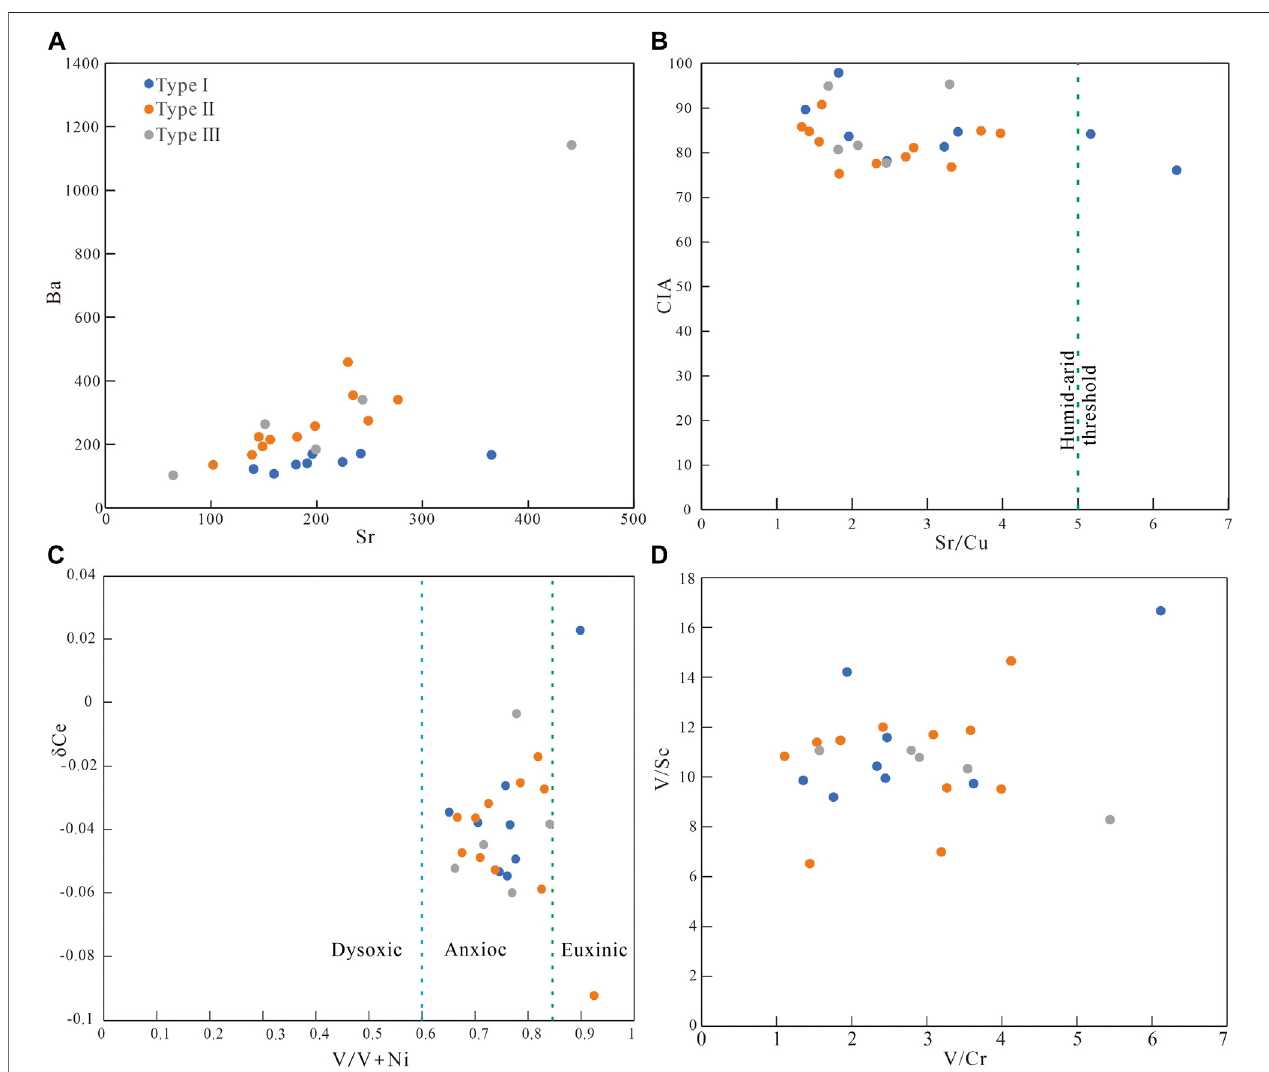
FIGURE 9 | Distribution diagrams of paleosalinity and redox proxies for siderite-bearing strata samples.